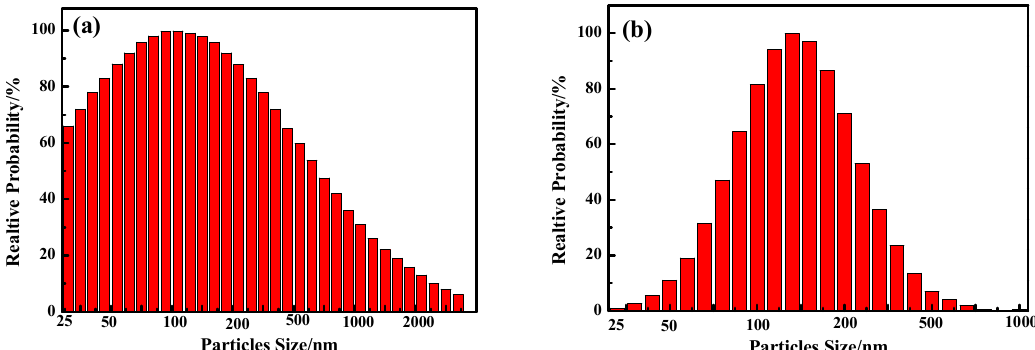
Figure 3. The size distribution of PTFE emulsion and TiO 2 sol: ( a ) PTFE emulsiom; ( b ) TiO 2 sol (note that the detection limit of the particle analyzer is 25 mm).